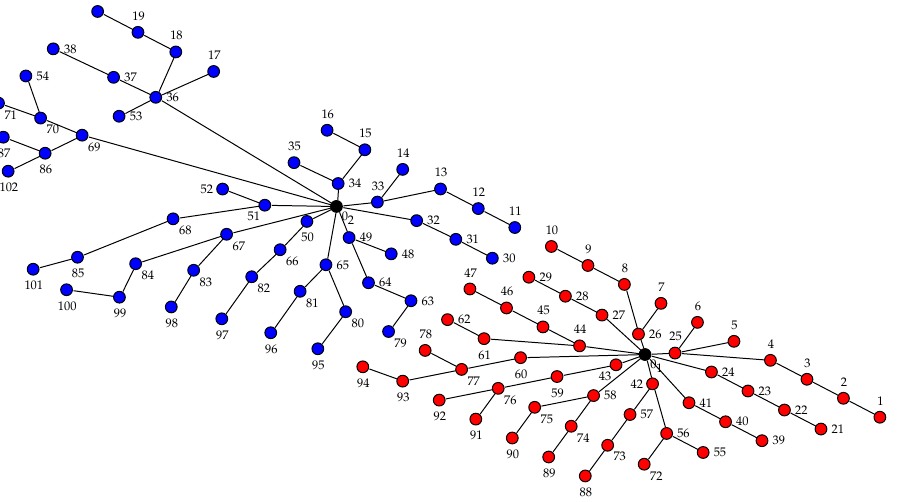
Figure 4. Optimal cable connection layout for WF-102-S2-W wind